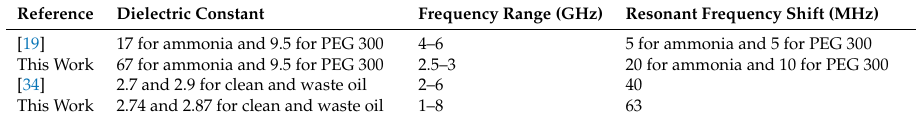
Table 2. Comparison of sensitivity for the rest chemical samples between our proposed structure and other in